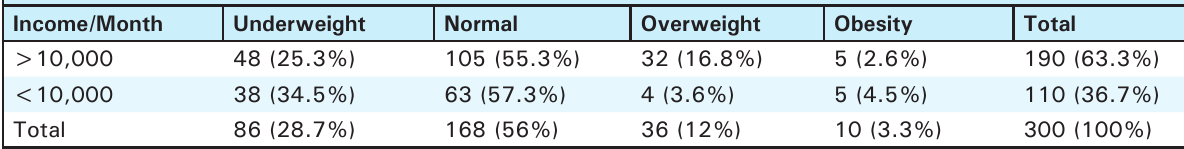
Table 4. Body Mass Index (BMI) and Monthly Family Incomes.